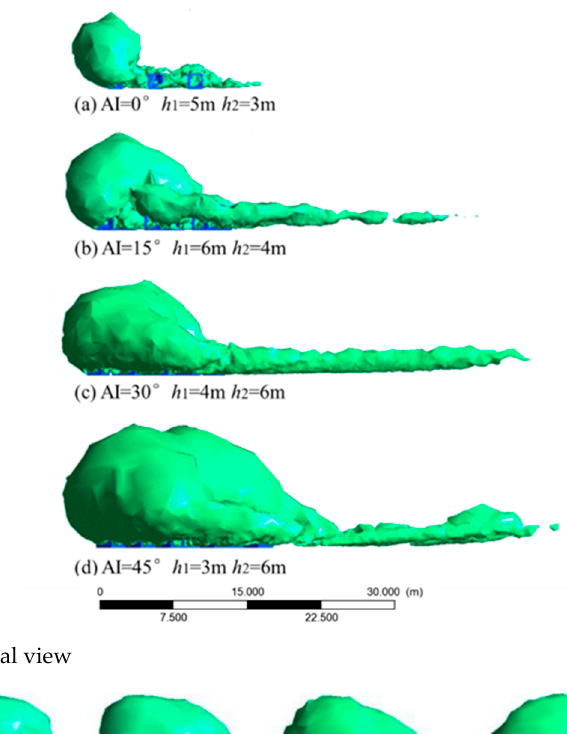
Figure 14. Upwelling and wake efficiency indices of the optimal URs with AI of 0°, 15°, 30°, and 45° .